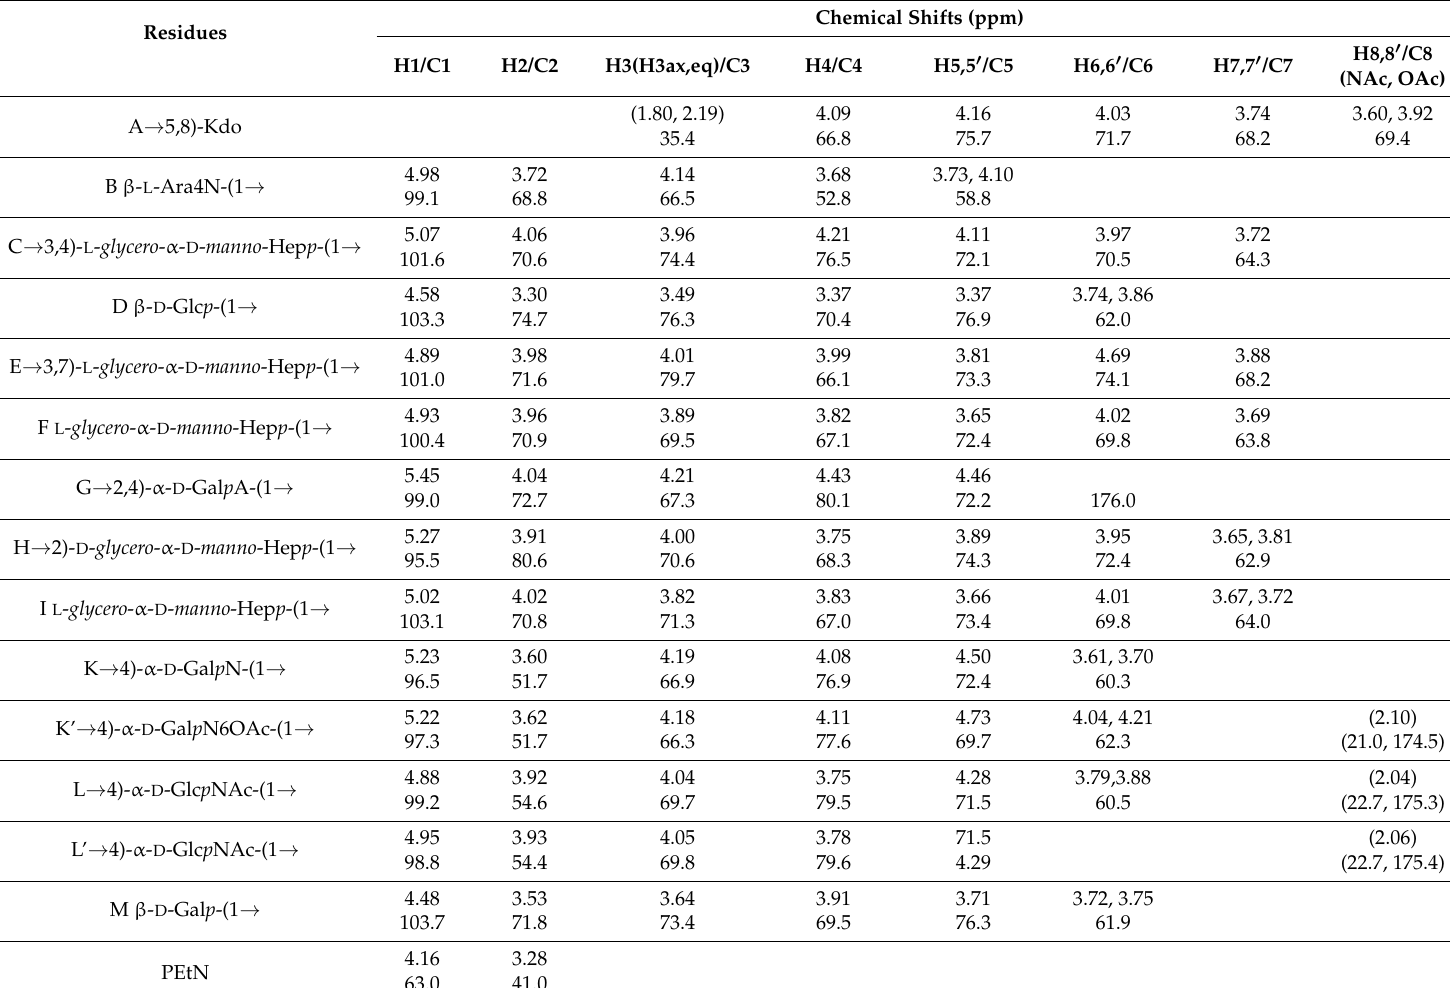
Table 2. 1 H and 13 C NMR chemical shifts of the core oligosaccharide of P. penneri 40A LPS.